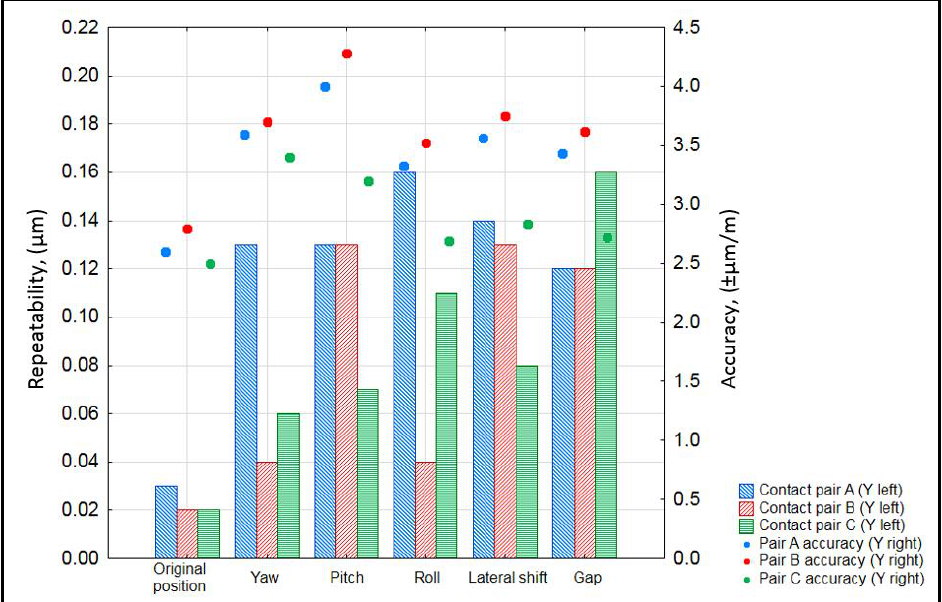
Figure 7. Accuracy and repeatability vs. different mounting conditions.